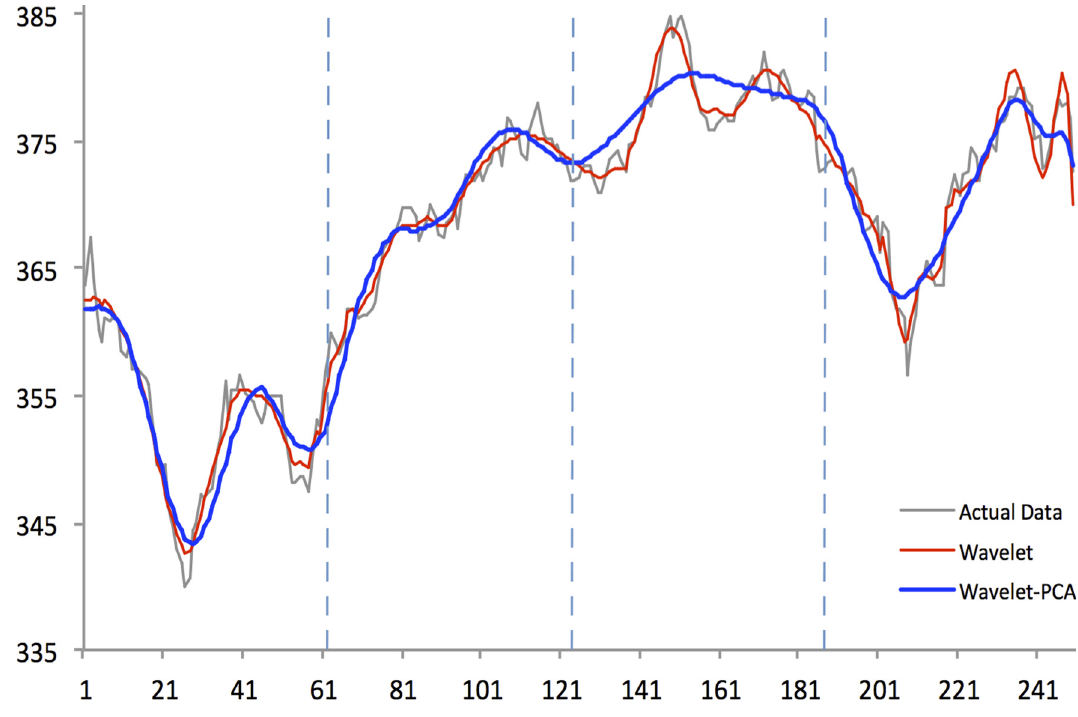
Fig 7. Univariate (Wavelet) and Multivariate (Wavelet-PCA) Denoising of SiMSCI futures 2014.